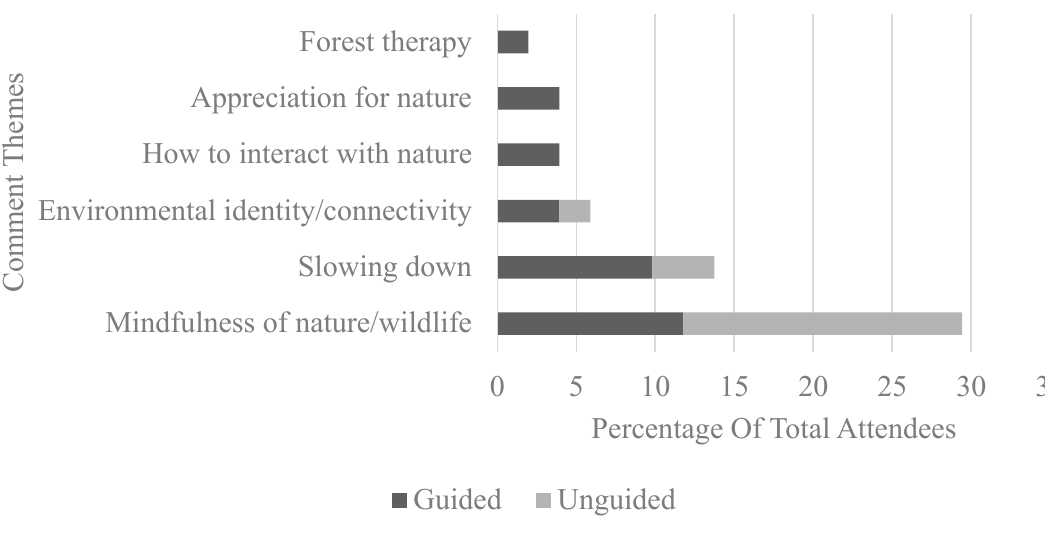
Figure 4. Reported learnings and / or improvements gained from the nature immersion session. Not all participants responded to open-ended items, so percentages do not represent the entire sample.